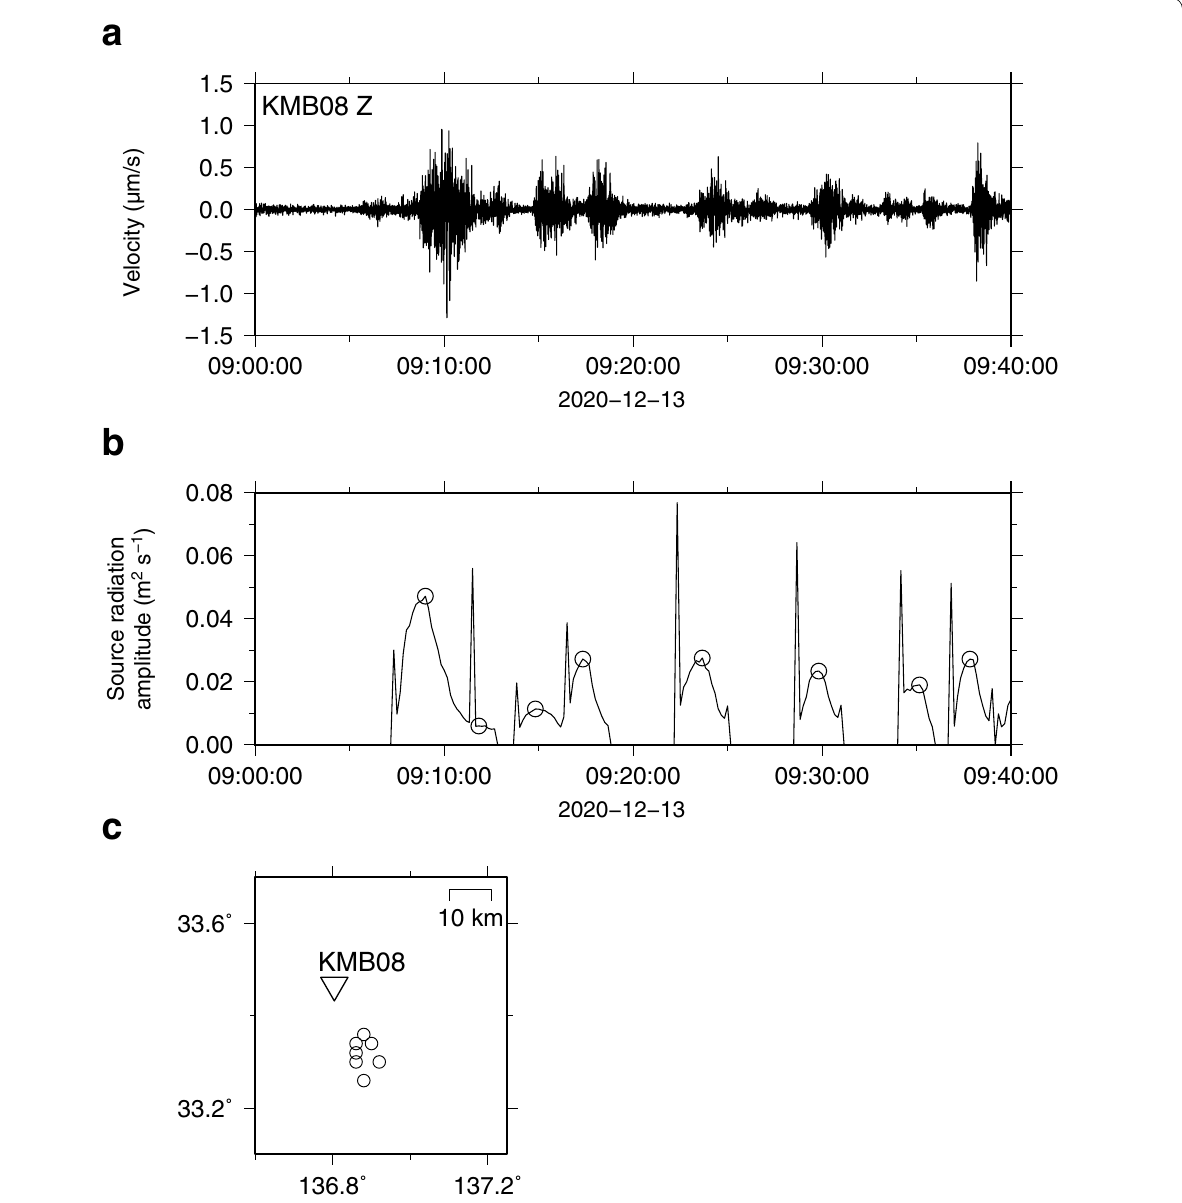
Fig. 2 a 2–8 Hz bandpass-filtered vertical-component waveform at station KMB08 and b temporal variation of source radiation amplitude between 09:00 and 09:40 on 13 December 2020. Circles denote the origin times of selected tremor locations after screening. c Locations of station KMB08 and the tremor events selected in a and